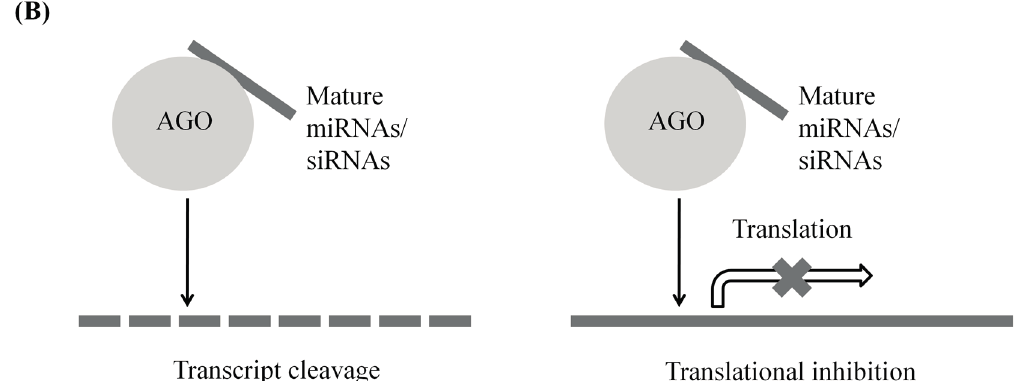
Figure 3. The roles of miRNA and siRNA in PTGS (post-transcriptional gene silencing).